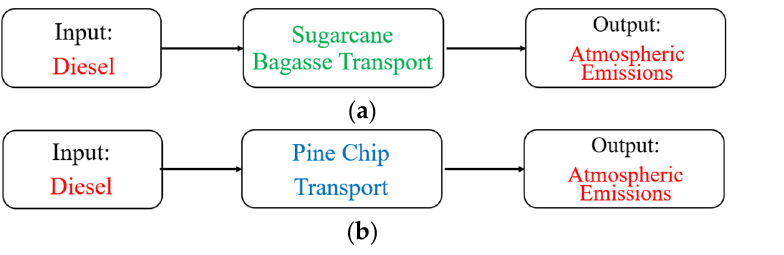
Figure 2. Transport Flowchart: ( a ) Scenario I and ( b ) Scenario II. Table 1. Inputs and outputs of the sugarcane transport process.